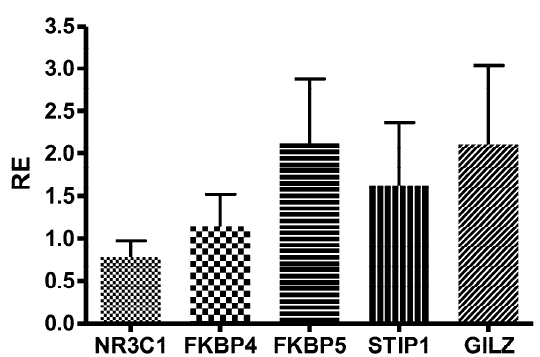
Figure 3. Relative expression (RE) of NR3C1, FKBP4, FKBP5, STIP1, and GILZ (calculated as 2 −ΔΔ C t T4 vs. T0). Parametric t -test Δ C t T0 vs T4.